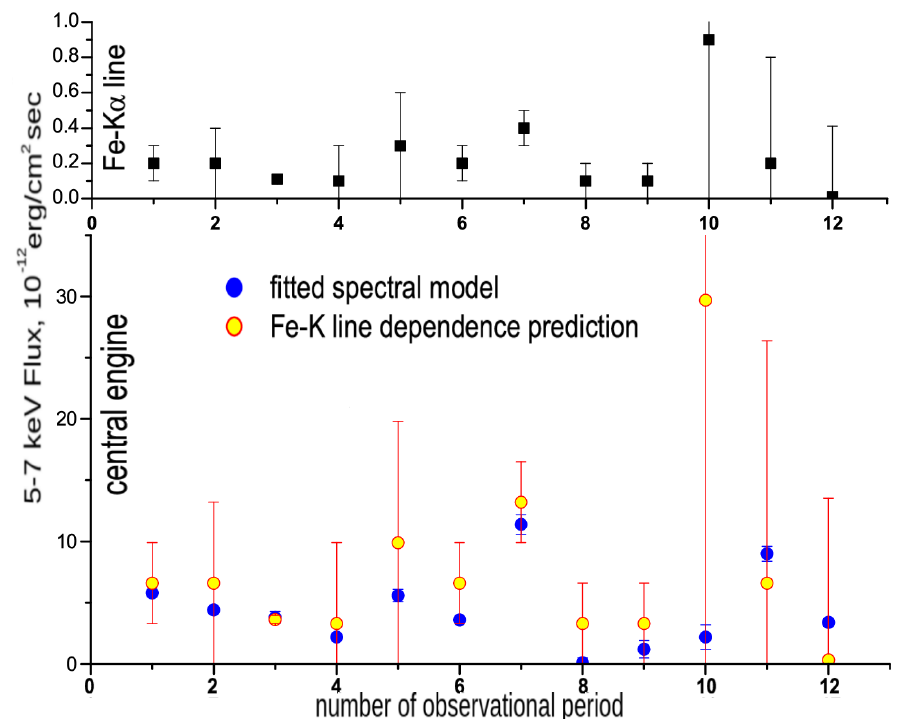
Figure 4. Fluxes in Fe K α line and primary nuclear ones for 12 observational periods derived by different methods. Upper panel: measured fluxes F line ∗ in Fe K α line. Lower panel: Primary nuclear 5 − 7 flux within 5–7 keV energy range F nucl ∗ , estimated using dependence (3) between nuclear and Fe K α line 5 − 7 emission (yellow circles with error bars, “prediction”) and F nucl ∗ of Table 3 (blue balls, “fitted 5 − 7